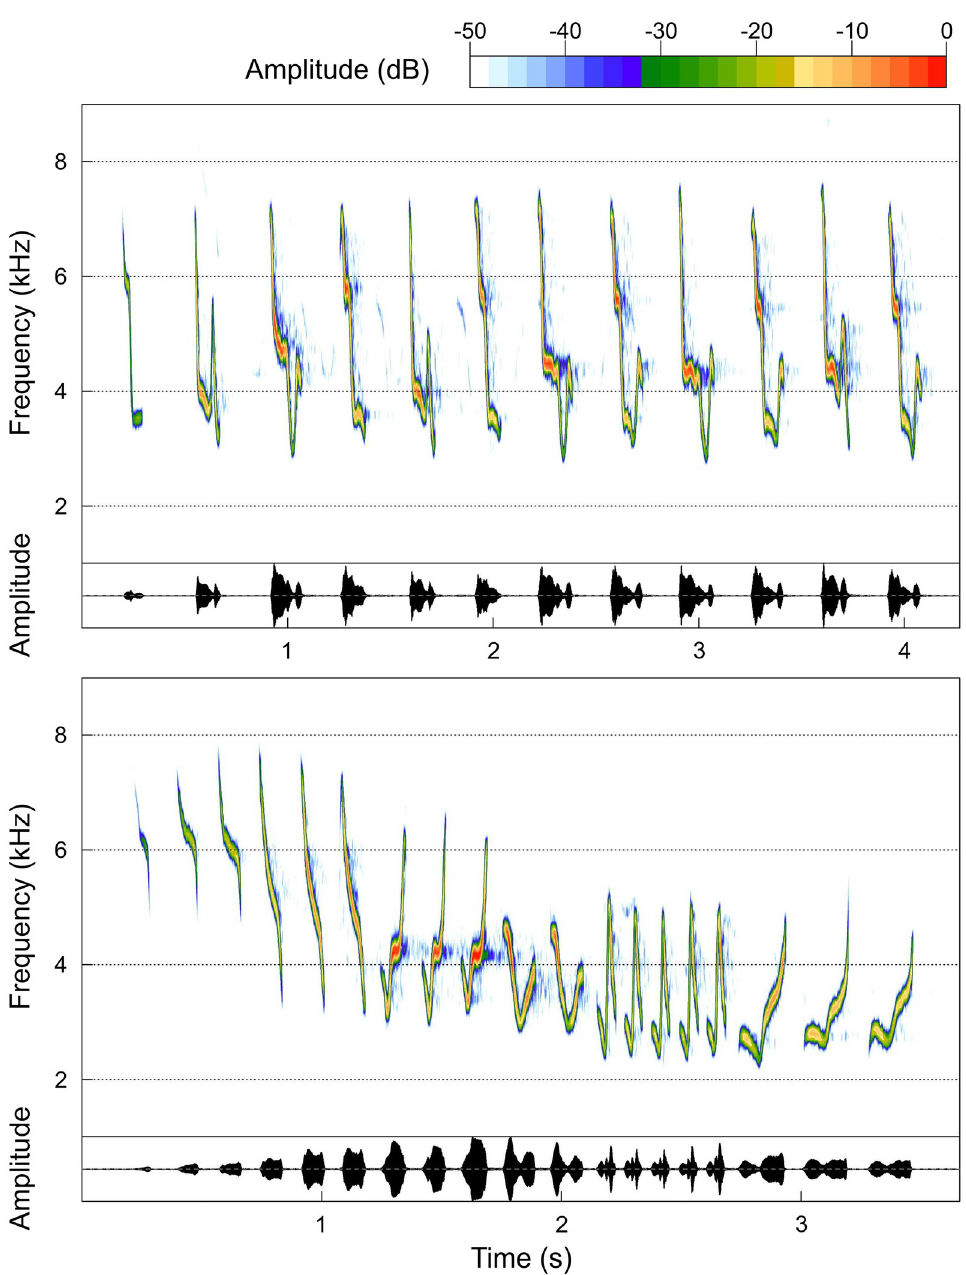
Fig 1. Spectrogram and oscillogram of typical Common Chiffchaff (upper) and Willow Warbler (lower) songs. Songs can differ from each other in the studied species, because they are composed of several different units, called syllables. The song of the Common Chiffchaff is composed of 12 syllables that belong to four unique syllable types. The song of the Willow Warbler is composed of 19 syllables that belong to six unique syllable types. Syllables can sometimes join into phrases, a repetition of a certain syllable type, as seen in the Willow Warbler song. Song nomenclature after Catchpole and Slater 2008